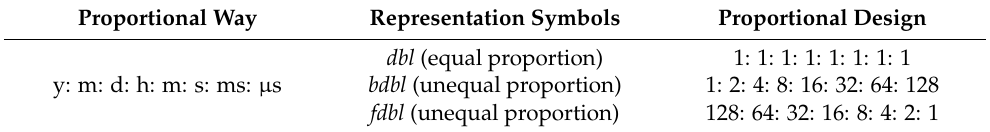
Table 3. Proportion designs in the temporal data set.